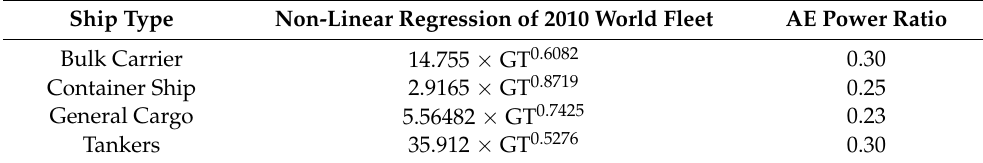
Table 1. Regression equation of main engine power and auxiliary engine ratio.